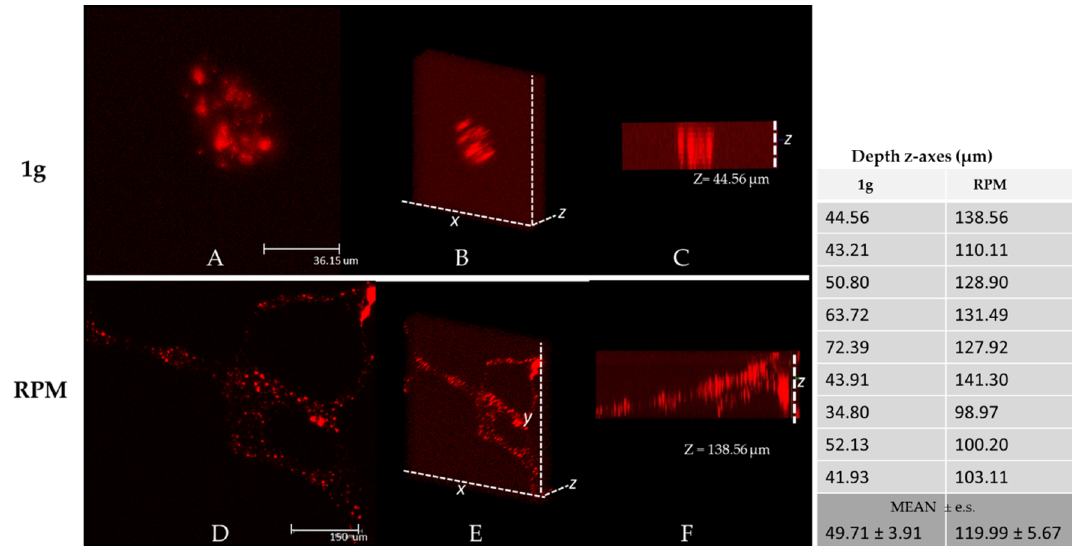
Figure 8. Representative images of Matrigel invasion by HaCaT after 24 h. HaCaT cells (red) were cultured on GFR Matrigel in normal gravitational condition (( A – C ), scale bar 7.5 µ m) and microgravity conditions (( D – F ), scale bar 150 µ m) for 24 h; ( A , D ) represent the confocal maximum projection; ( B , E ) represent 3D projection; ( C , F ) shows the depth analysis. As shown in this figure, HaCaT cells maintained at unit gravity invade matrix up to a depth of about 44.56 µ m ( C ), while cells maintained in the microgravity condition are able to invade to a depth of about 138.56 µ m ( F ). The table indicates the depth along the zeta axis measured in the three experiments performed (1g vs. RPM p < 0.001).